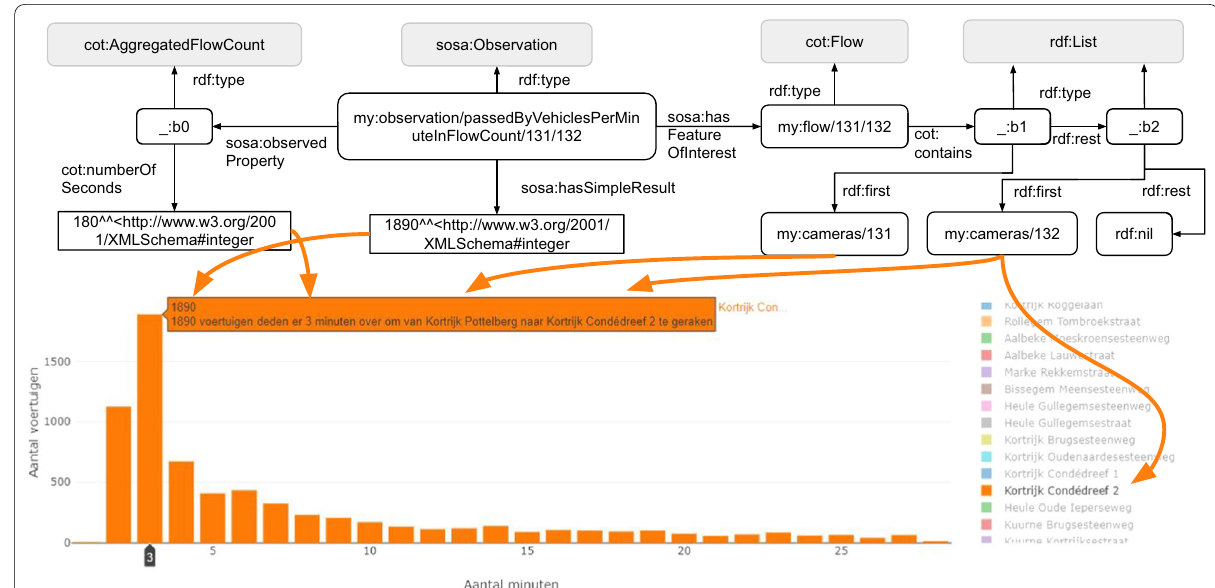
Fig. 8 Travel time estimation visualization. Distribution of the number of minutes that is needed to travel between two ANPR